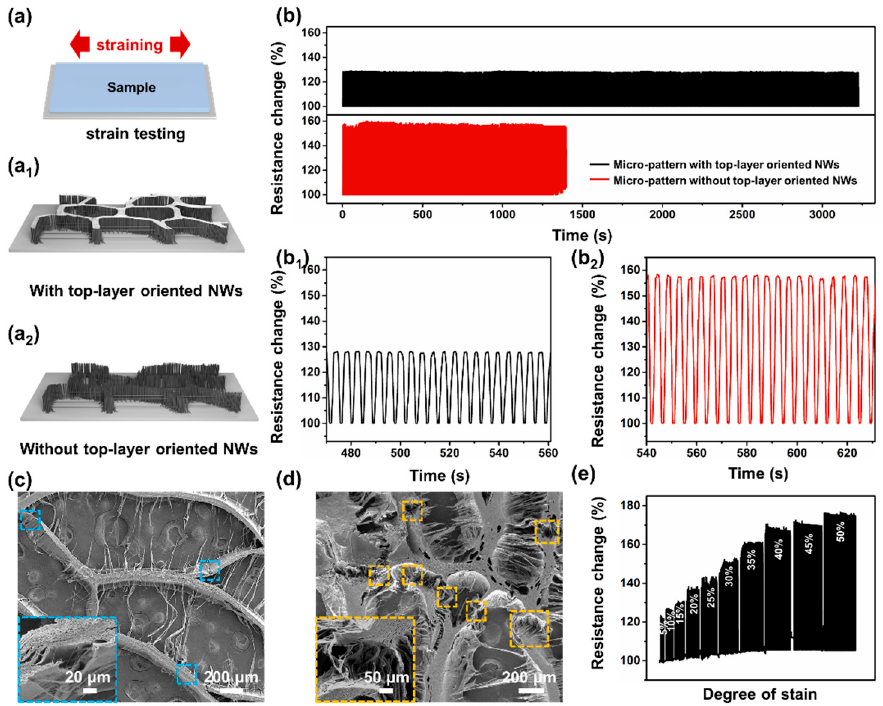
Figure 4. The performance of the multidimensional aligned NWs array-based sensor. ( a ) Schematic depiction for the stretching process. ( a 1 , a 2 ) A schematic of multidimensional aligned NWs array with and without oriented NWs on top layer as strain sensor. ( b ) Change in resistance under stretching/releasing motion of 10% strain for 300 cycles, showing the durability of the NWs array with top-layer oriented NWs. ( b 1 , b 2 ) The typic enlarged view of Figure 4b for the NWs array with and without oriented AgNWs on top layer, respectively. ( c , d ) The SEM image of NWs array with and without oriented NWs on the top layer after 300 stretching cycles. The insert shows the local enlarged picture. ( e ) The electrical response of the as-prepared multidimensional aligned NWs array under stretching/releasing motion at different strain degree of 5%, 10%, 15%, 20%, 25%, 30%, 35%, 40%, 45%, and 50%, respectively.